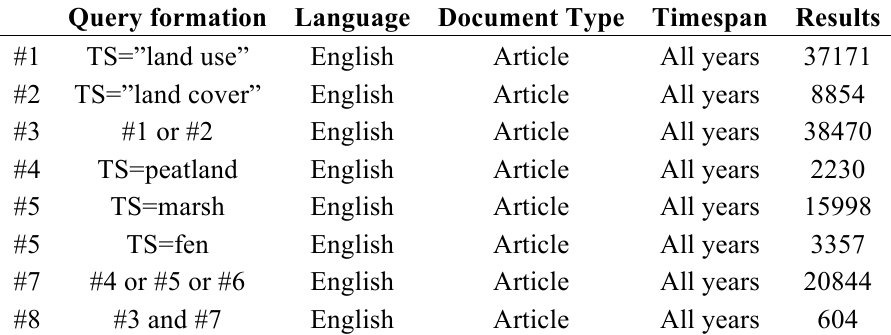
Table 1. Literature query formation in Web of